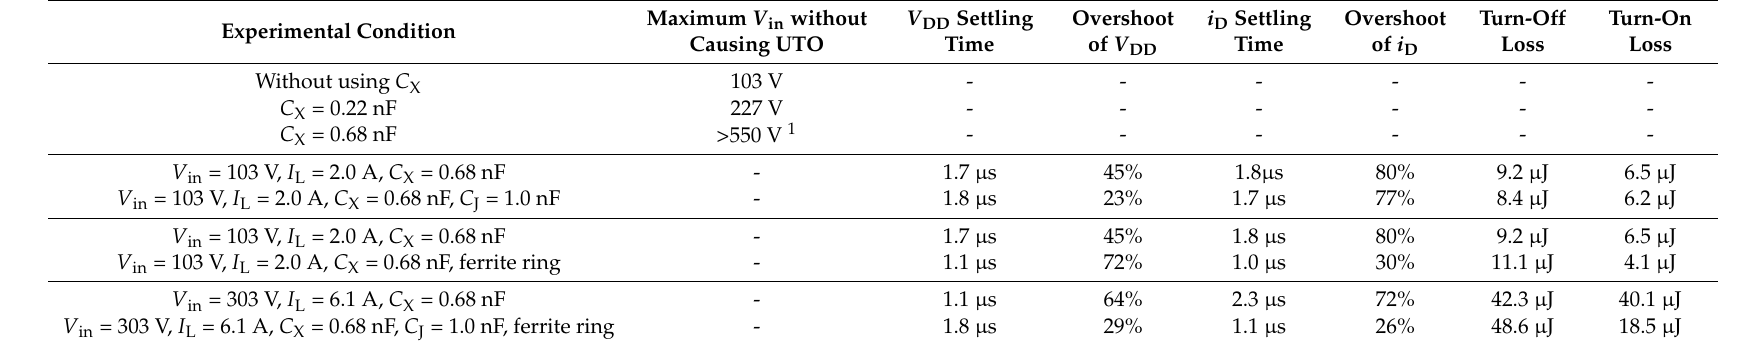
Table 2. Comparison of experimental data under different